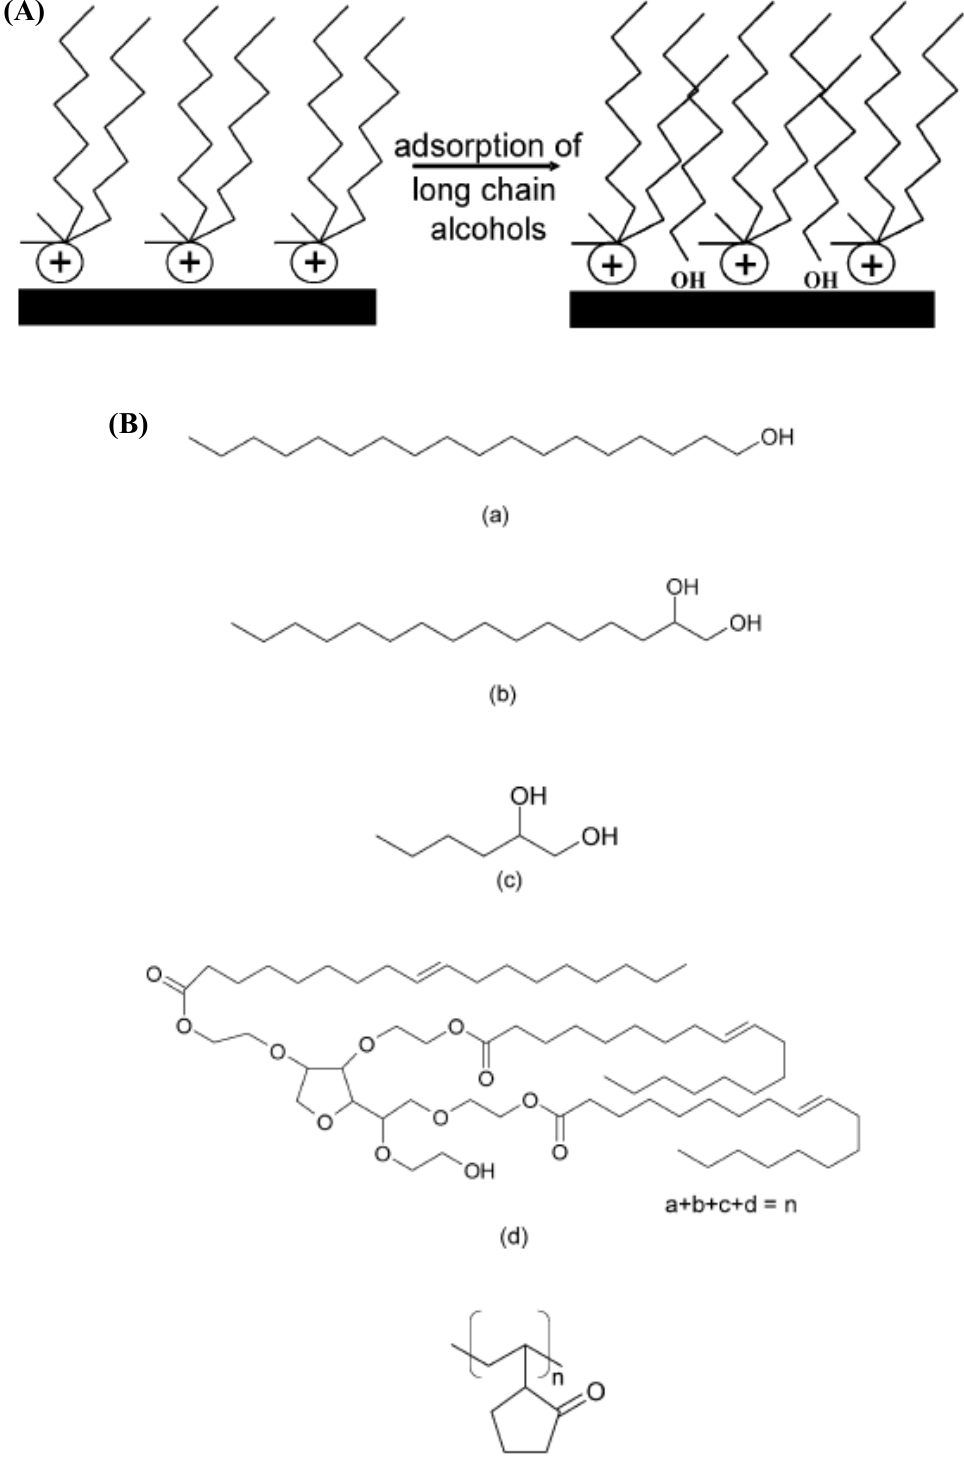
Figure 26. (A) Representation of physical adsorption process and (B) chemical structures of the adsorbents used for adsorption on the clay surface: (a) 1-octadecanol, (b) 1,2- hexadecanediol, (c) 1,2-hexanediol, (d) Tween 85 and (e) poly(vinylpyrrolidone) (PVP). Reproduced from reference [128] with permission from